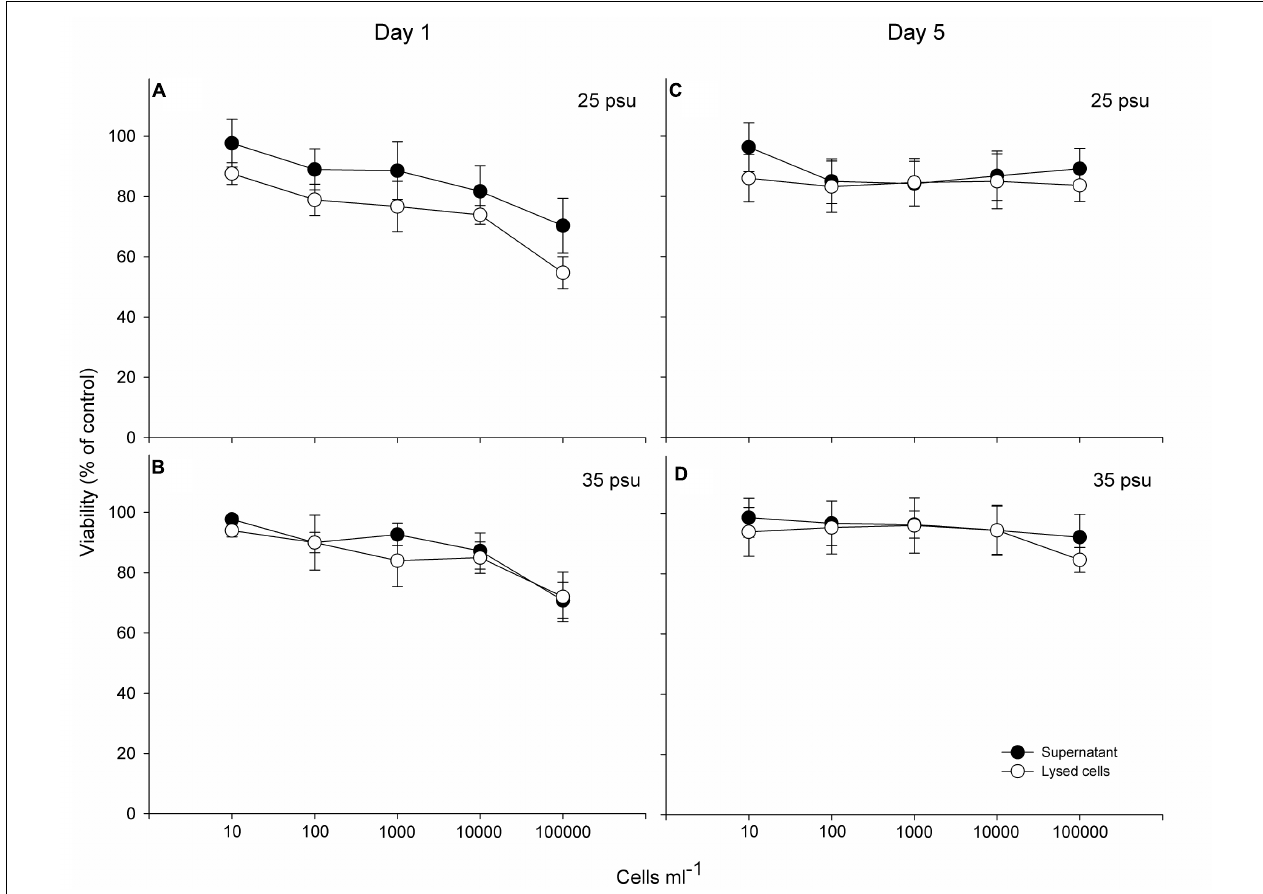
FIGURE 5 | Concentration-dependent toxicity (supernatant and lysed cells treatments) of the Pseudochattonella ARC498 strain at 1 (A,B) and 5 days of culture harvest (C,D) (at 25 and 35 psu) to the cell line RTgill-W1. Symbols represent the mean and error bars the SD of cell viability from quadruplicate